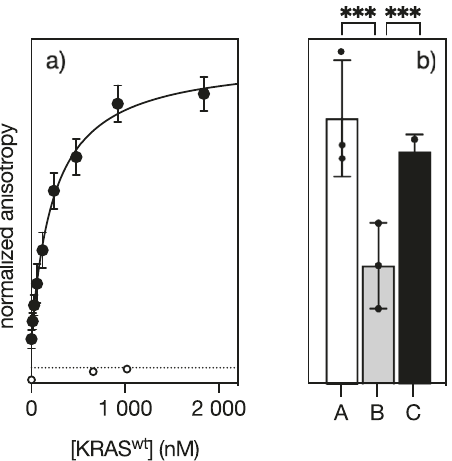
Fig. 5 Binding of the metallopeptide α H-His 2 [Pd] to KRAS inhibits the nucleotide release process. Preformed α H-His 2 [Pd] increases the displacement of mantGTP bound to KRAS wt . a normalized emission at 430 nm. Black triangles: intrinsic nucleotide displacement curve of a 1 μ M solution of the preformed KRAS wt /mantGTP complex; white circles, same solution in the presence of 10 μ M α H-His 2 ; black circles: same KRAS wt / mantGTP solution in the presence of 10 μ M α H-His 2 [Pd]. b half-life of the kinetic traces shown on the left. A intrinsic KRAS wt /mantGTP complex; B with α H-His 2 ; C with α H-His 2 [Pd]. Data were subjected to a One-Way ANOVA statistical analysis, *** p <